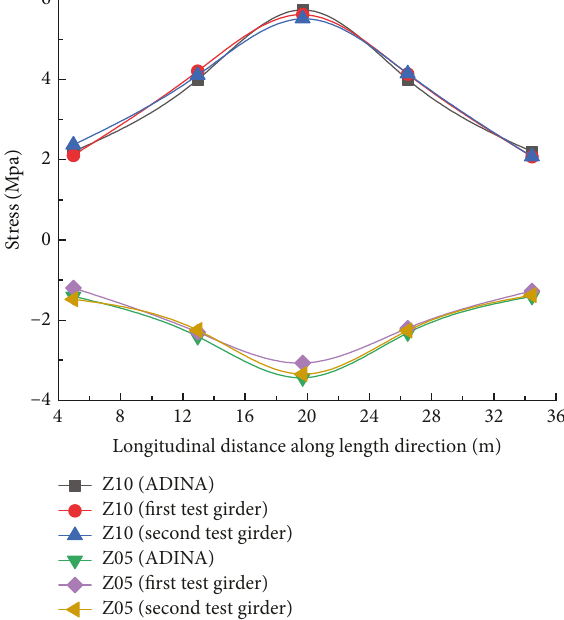
Figure 14: Stress increment along the girder length